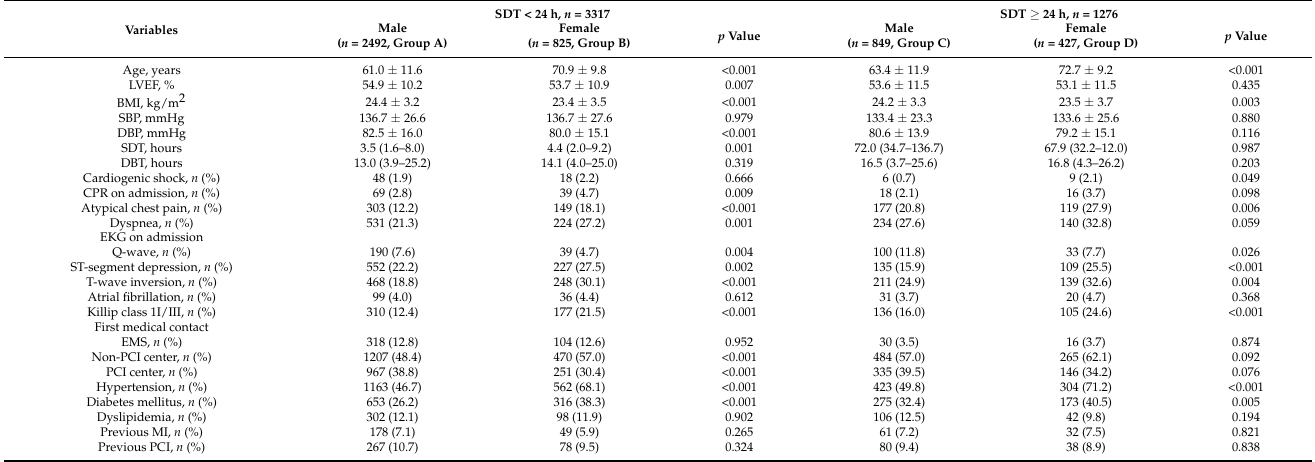
Table 1. Baseline